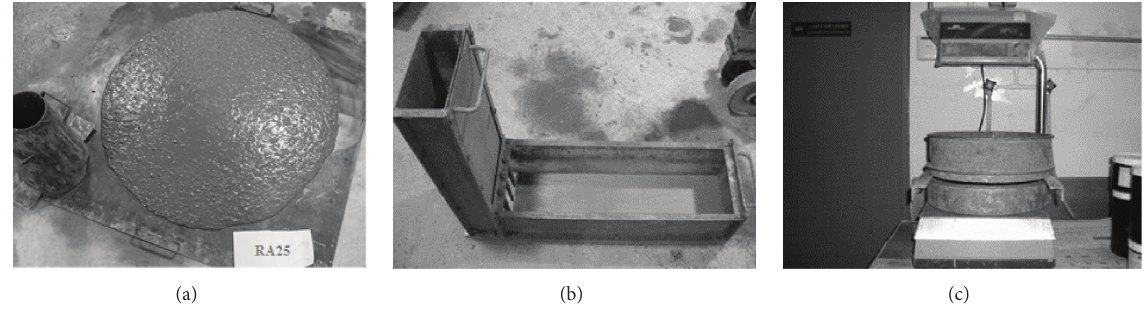
Figure 1: (a) Slump flow tests, (b) L-box test, and (c) sieve segregation test.